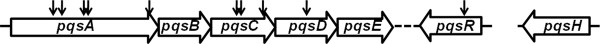
The pqs locus and transposon insertions in associated suppressor mutants. Horizontal arrows represent the genes of the pqsA-E operon, the pqsR transcriptional regulatory gene, and the pqsH gene. Small vertical arrows indicate the location of the respective transposon insertions.